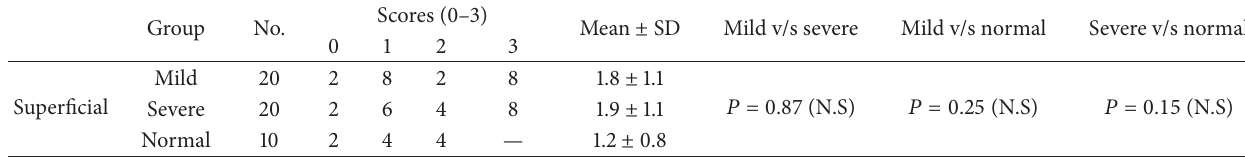
Table 2: Pattern of vimentin scores at deep localization in mild OSF cases, severe OSF cases, and control group. Group